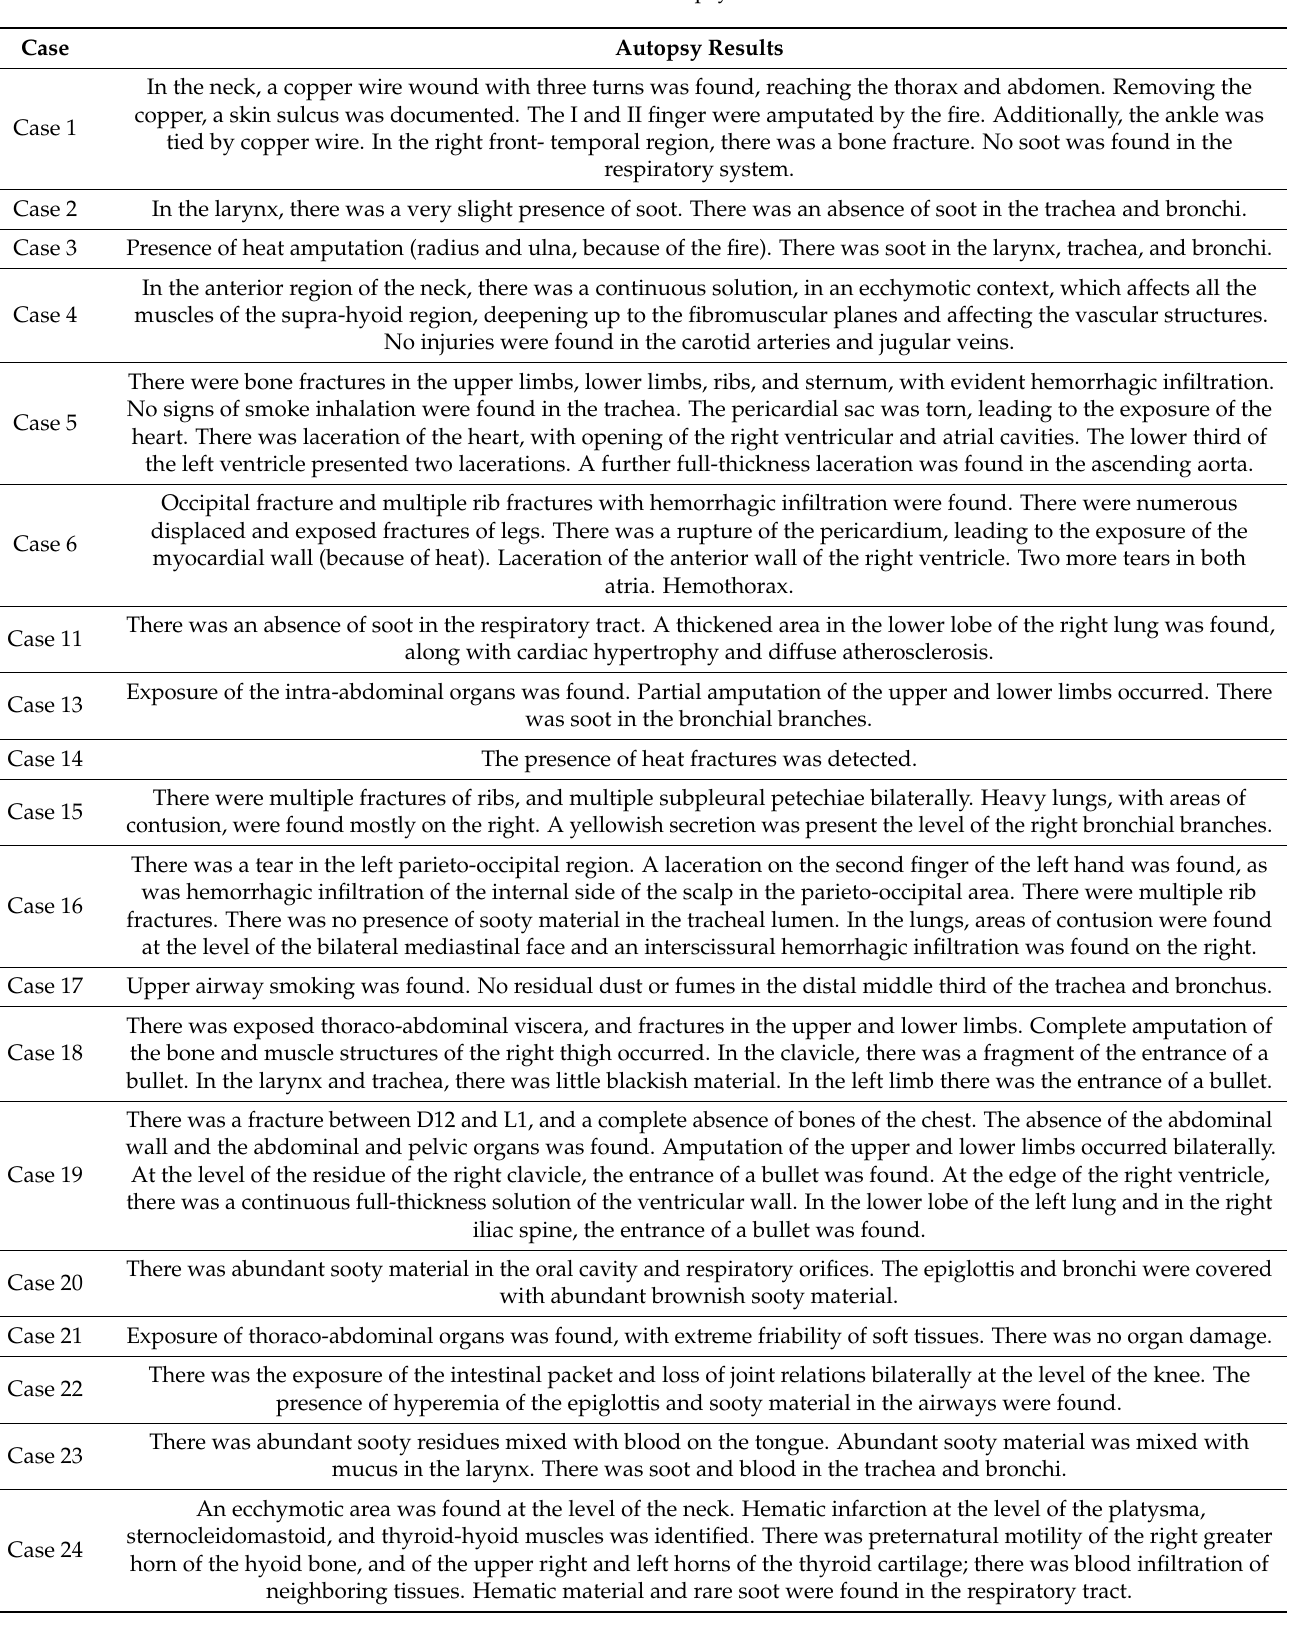
Table 4. The table summarizes the autopsy examinations in 66/82 cases of charred